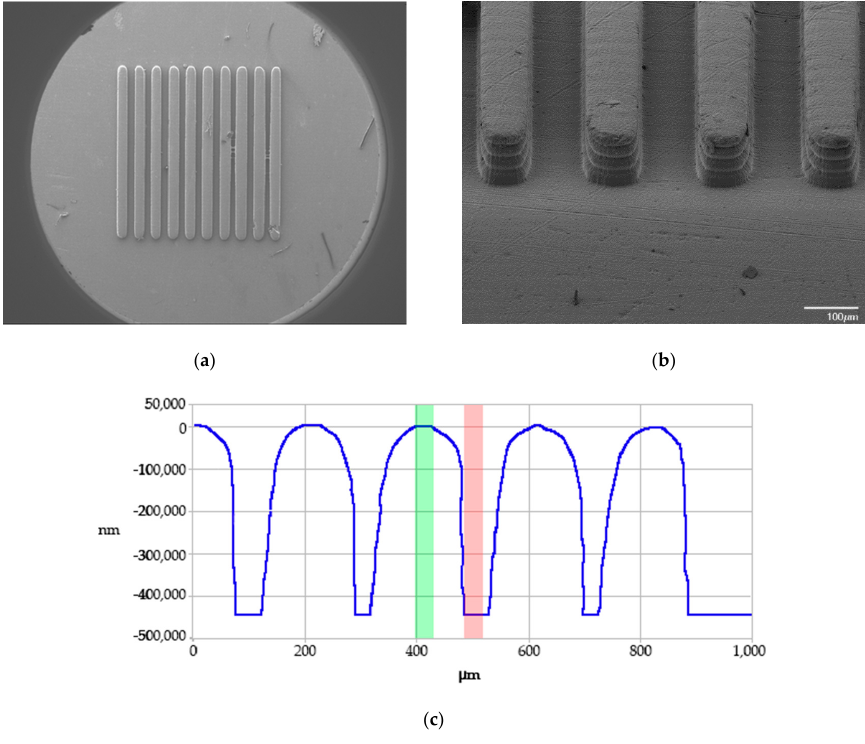
Figure 5. Group B tooling: ( a ) SEM image of the top of features, ( b ) SEM image of isometric view of features, and ( c ) contact profilometry trace of these features.